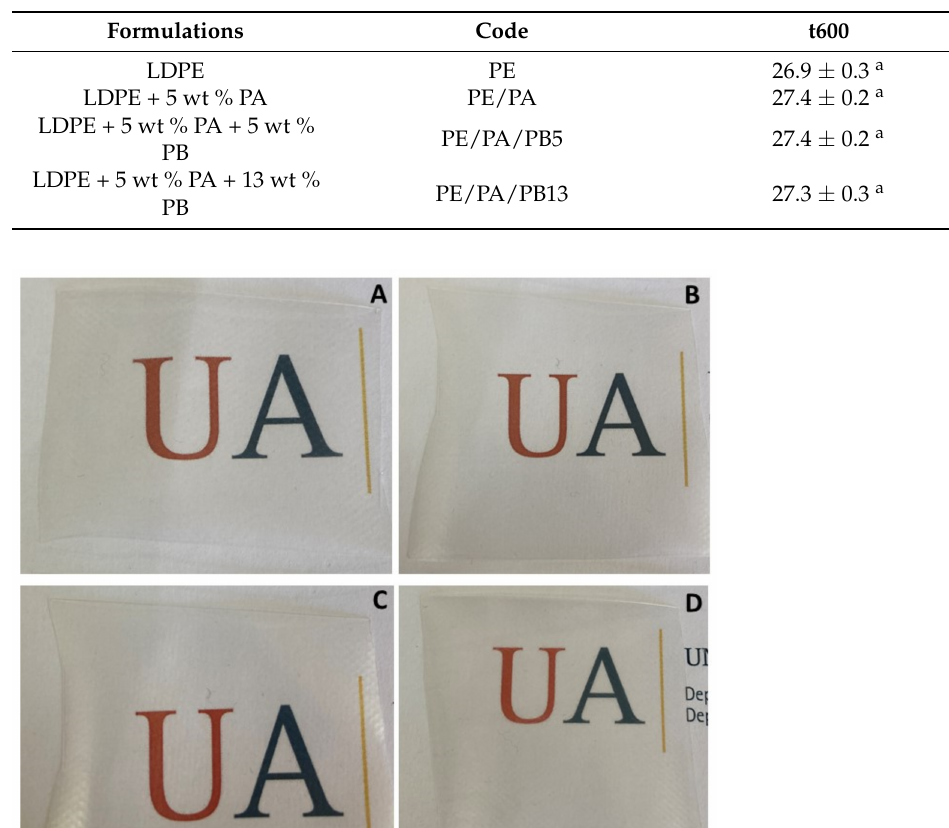
Table 1. Different developed formulations, their codification and transparency at 600 nm (t600) (mean ± SD, n = 3). Same superscripts within the same column indicate no statistically significant different values ( p < 0.05).